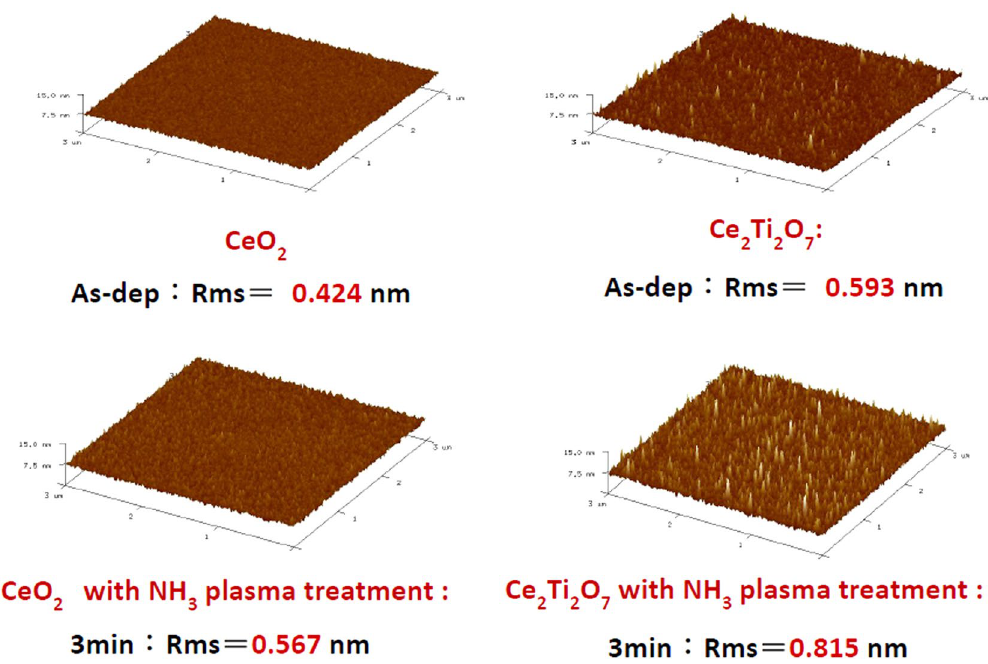
Figure 4. AFM images of the CeO 2 sample without NH 3 plasma treatment and with NH 3 plasma treatment for 3 min. The normalized C-V curve of the Ce 2 Ti 2 O 7 sample without and with NH 3 plasma treatment for 3